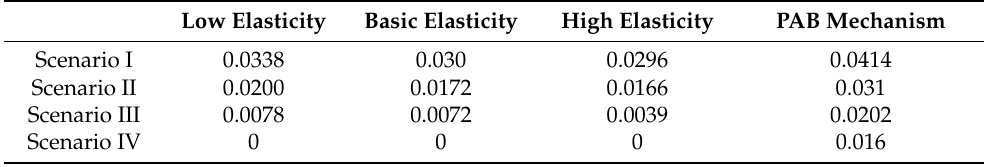
Figure 5. Evolution results of installed capacity of PAB mechanism and supply–demand adjustment mechanism in Scenario I and Scenario II. Table 4. The average growth rate of market installed capacity in the planning period under the PAB mechanism and the supply–demand adjustment mechanism considering different elasticity in different